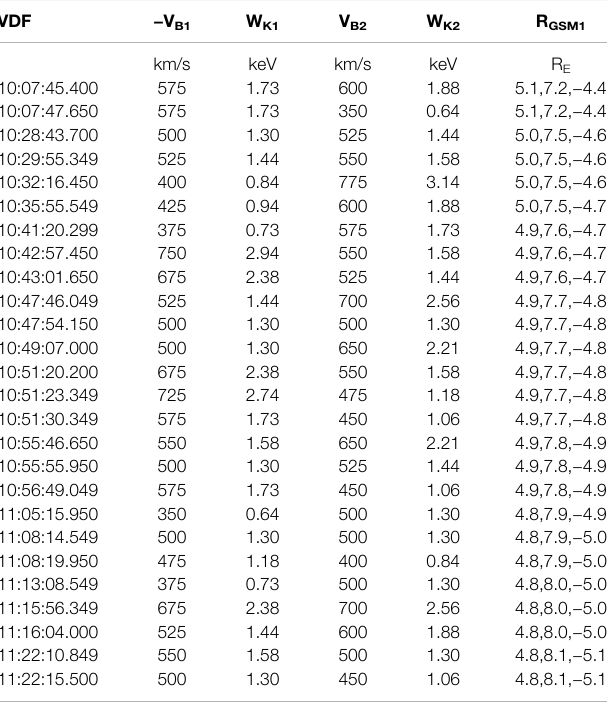
TABLE 2| Times ofindividual ionVDFs as recorded by MMS-1 thatdisplayed two distinct counter-streaming ion beams and superposed on a slowly drifting magnetosheath ion core